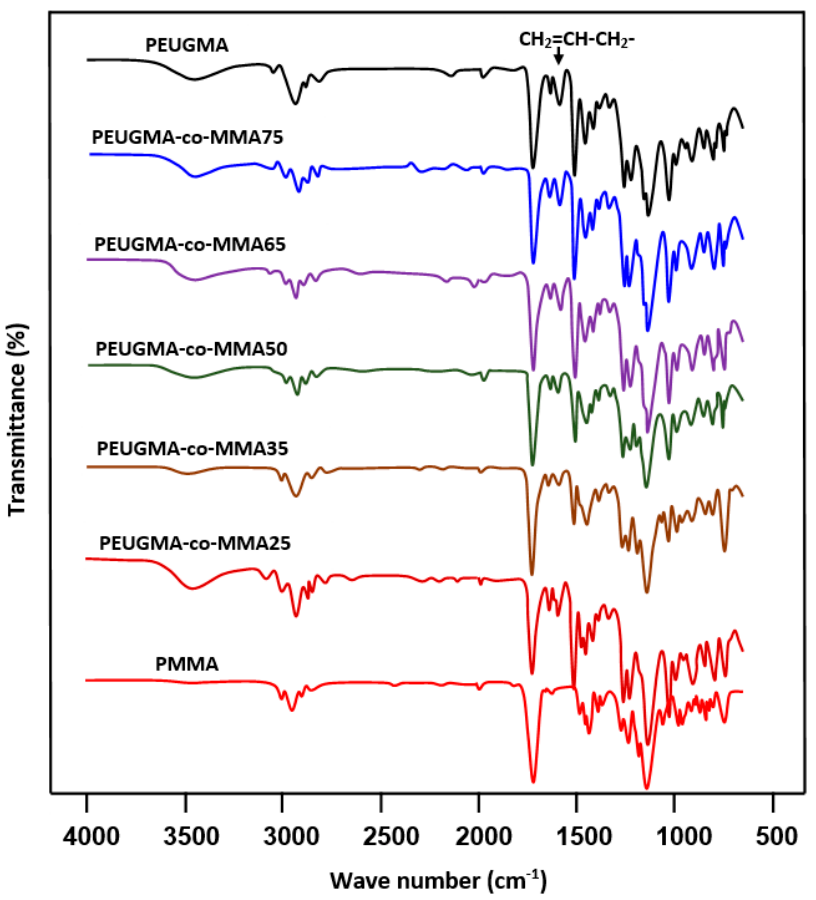
Figure 6. FTIR spectra of PEUGMA-co-MMA copolymers and those of their corresponding homopolymers MMA and EUGMA.